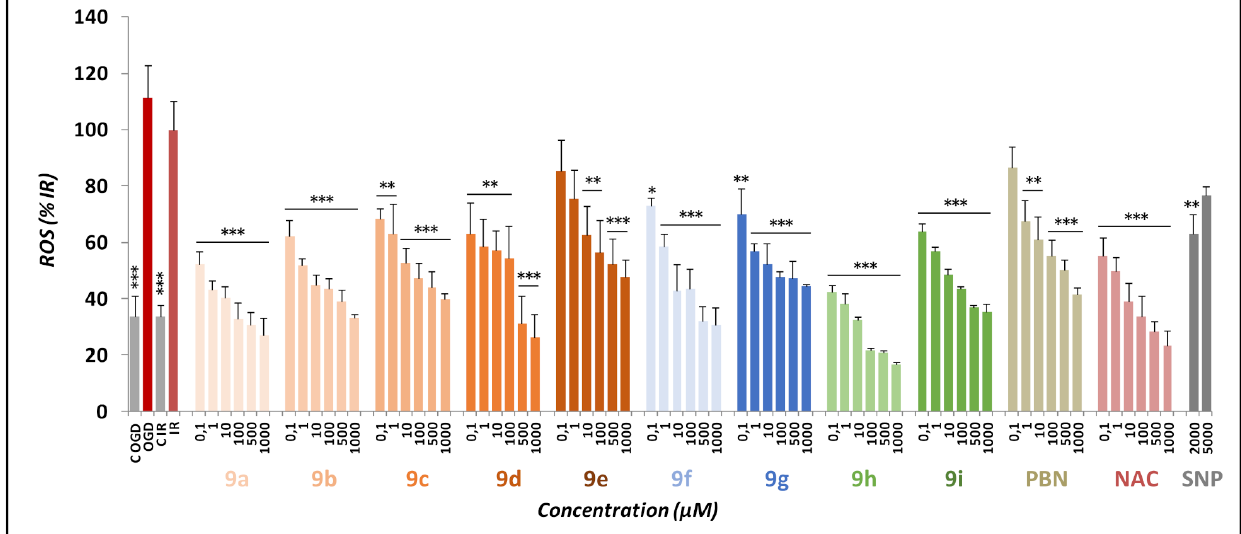
Figure 9. Inhibitory effects of nitrones 9a – i , PBN , and NAC on superoxide production in SHSY5Y cell cultures exposed to OGD (4 h) and 3 h OGR (IR). Bars represent the percentage of ROS formed after OGD and OGR (IR), in the absence and presence of nitrones 9a – i or PBN and NAC , at the specified concentrations. Values are mean ± SEM of at least four experiments, each one performed in triplicate. Data for ROS in basal conditions were of 0.101 ± 0.022 AFU/min/100,000 cells. Data presentation, curve fitting and statistical analysis of the data was performed as shown in Figure 3. The statistics compares the effect of IR versus controls or the effect of the different compounds vs. IR alone. * p < 0.05, ** p < 0.01, and *** p <